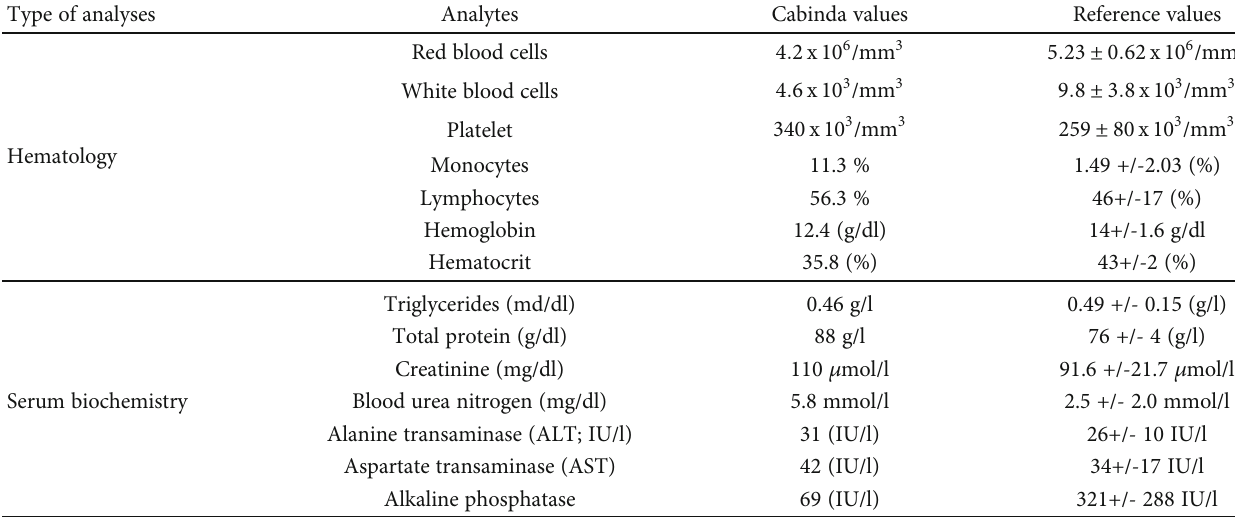
Table 1: Hematologic and serum biochemical analyses for chimpanzee Cabinda. Reference values are those applied at the CIRMF Primatology Center (unpublished data on 650 samples from 156 adult male chimpanzees over 15